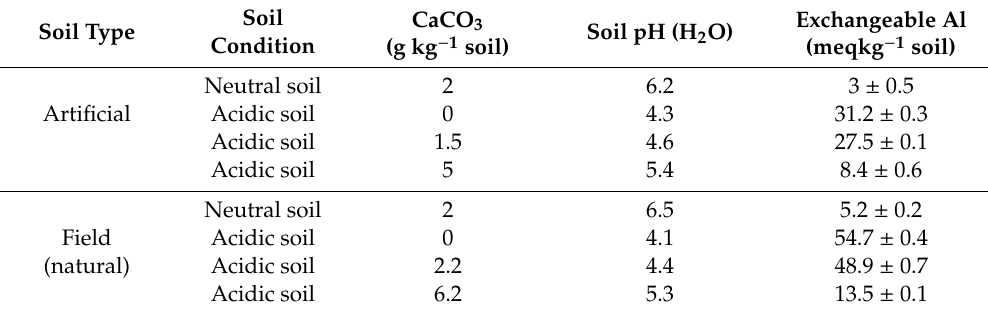
Table 2. E ff ect of CaCO 3 supply on pH and exchangeable Al in artificial and natural soils Soil CaCO 3 Soil Type Condition (g kg − 1 soil) Neutral soil Artificial Acidic soil 0 Acidic soil